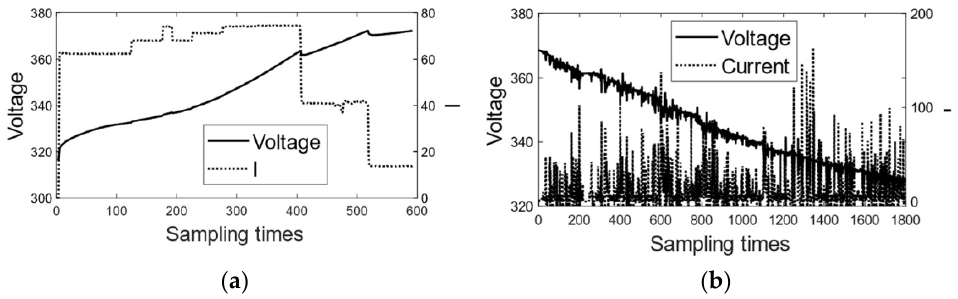
Figure 3. The voltage and current data acquired form NEVs, ( a ) charging data; ( b ) discharging data.